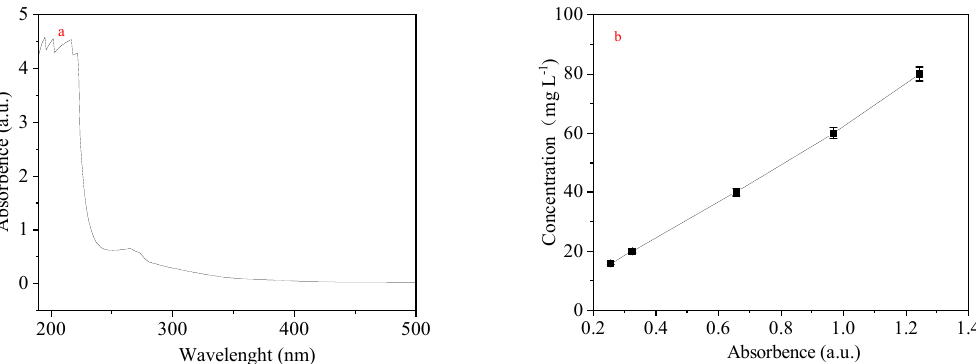
Figure 6. ( a ) UV–vis absorption spectra of 30 mg L − 1 phenol wastewater; ( b ) standard curve of absorbance–phenol concentration.